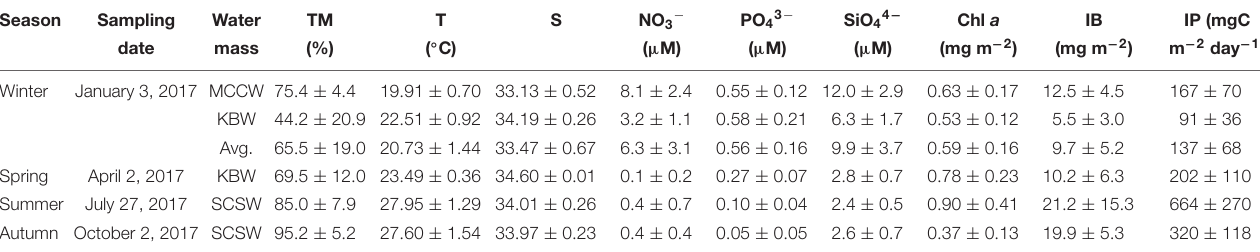
TABLE 2 | Seasonal properties of water masses [average light transmission (TM%), temperature (T), salinity (S), NO 3 − , PO 43 − , SiO 44 − , and Chl a throughout the water column, euphotic zone integrated Chl a concentration (IB), and euphotic zone integrated primary production (IP) of each water mass]. Season Sampling